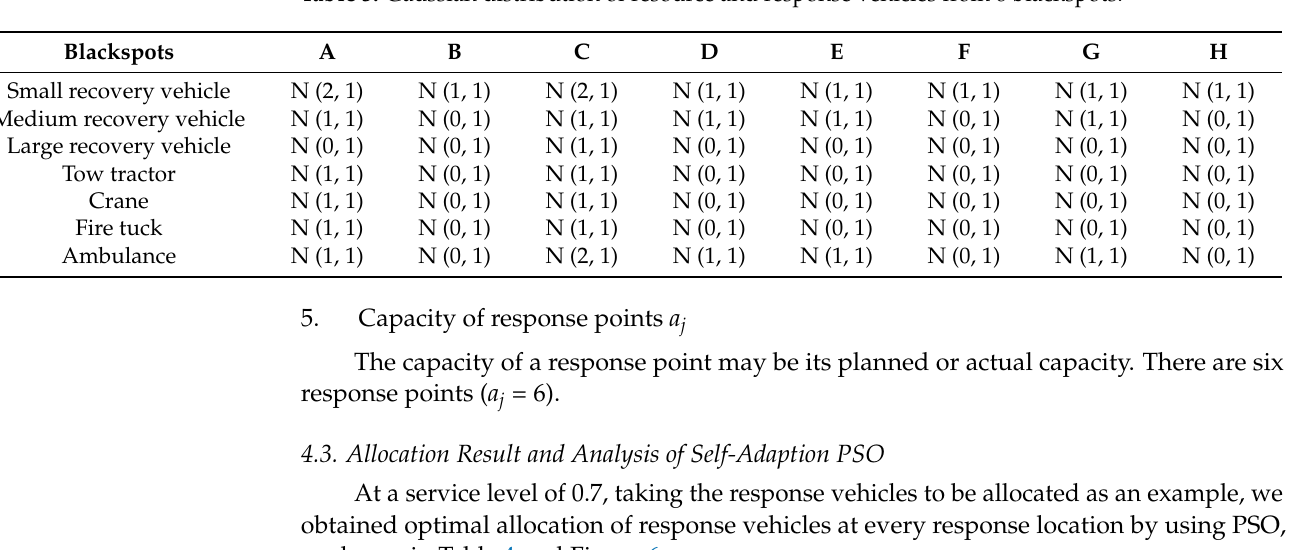
Table 3. Gaussian distribution of resource and response vehicles from 8 blackspots.